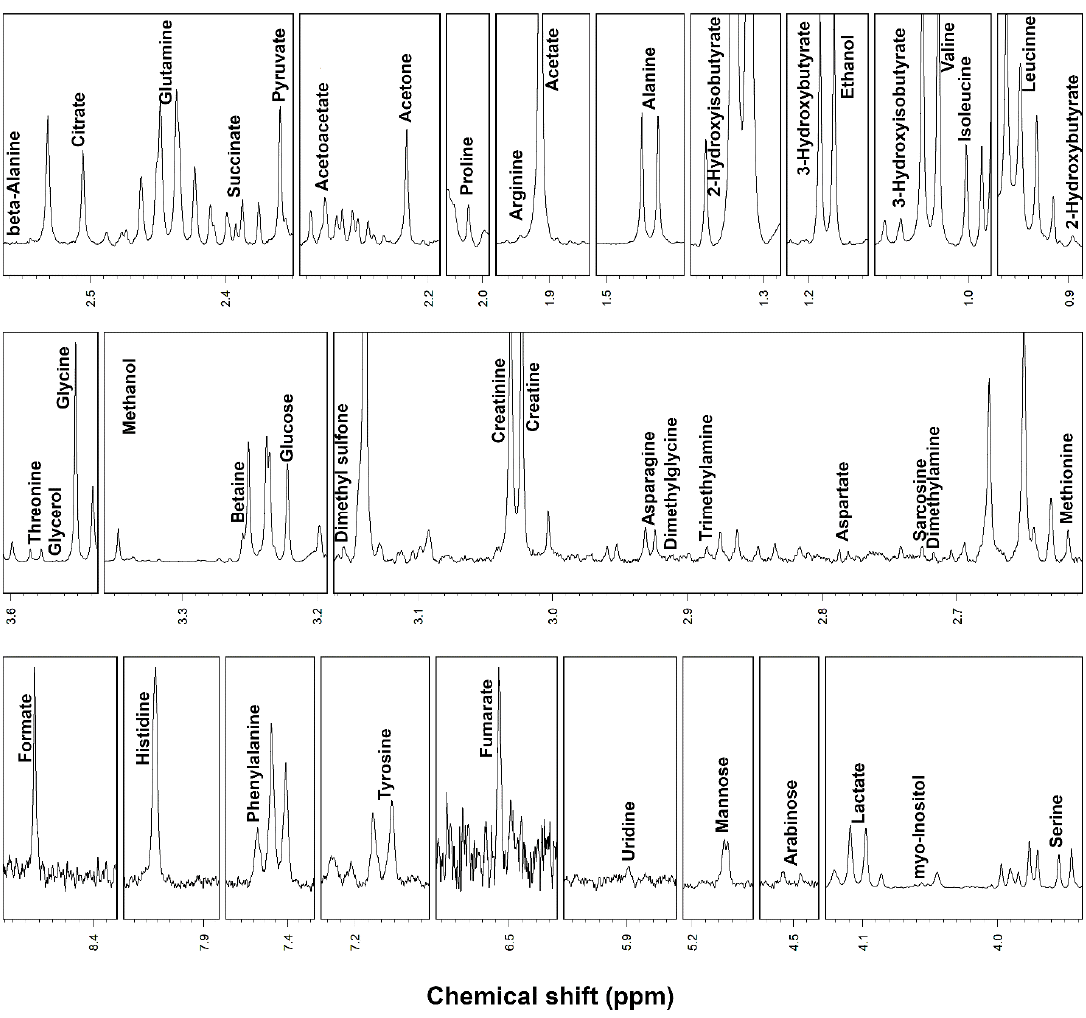
Figure 1. Portions of 1 H-NMR spectra from typical serum samples. Assignments appear on the signals used for molecules quantification. The vertical scale of each portion is conveniently set to ease the signals observation.